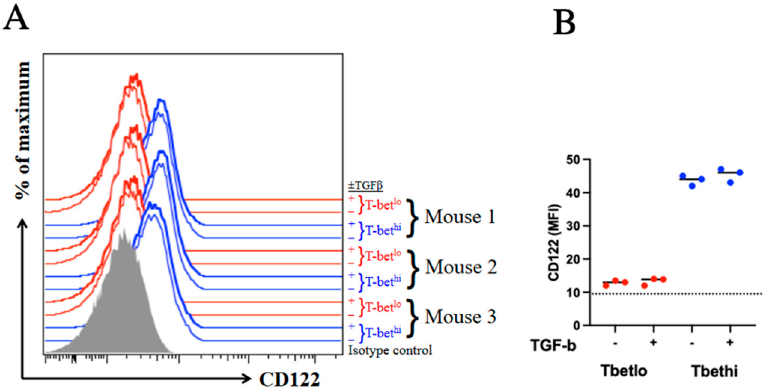
Figure 5. CD122 expression is not significantly affected by TGF β signaling. Endogenous MPECs and SLECs were incubated with or without 20 ng/mL TGF β for 2 h prior to the analysis of CD122 expression by flow cytometry ( A ). Gray-filled histogram represents isotype control. T-bet hi SLECs and T-bet lo MPECs from individual mice are represented by blue and red histograms, respectively. ( B ) CD122 MFI are compared between groups; p > 0.05. The experiment was conducted using three mice per group and repeated twice.